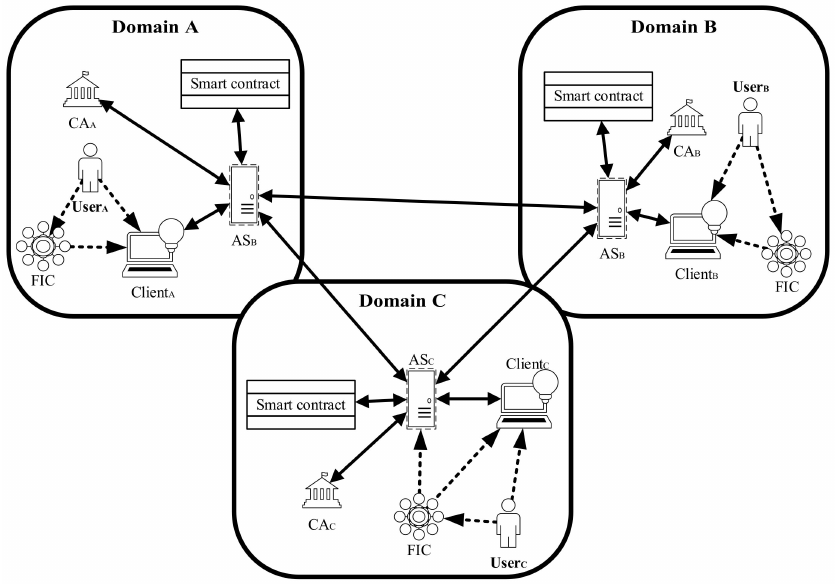
Figure 1. System structure of consortium blockchain. Each domain has an independent user and device, and different domains communicate with each other through the consortium